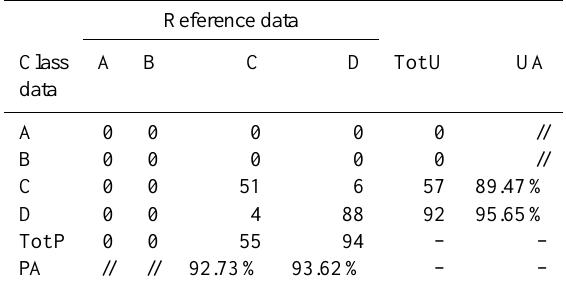
Table 10. Confusion matrix for the radial basis function network classifier evaluated on the test set TeS (cid:127) with elevation above 2200m; Class A: absence of snow cover, Class B: 1–10cm, Class C: